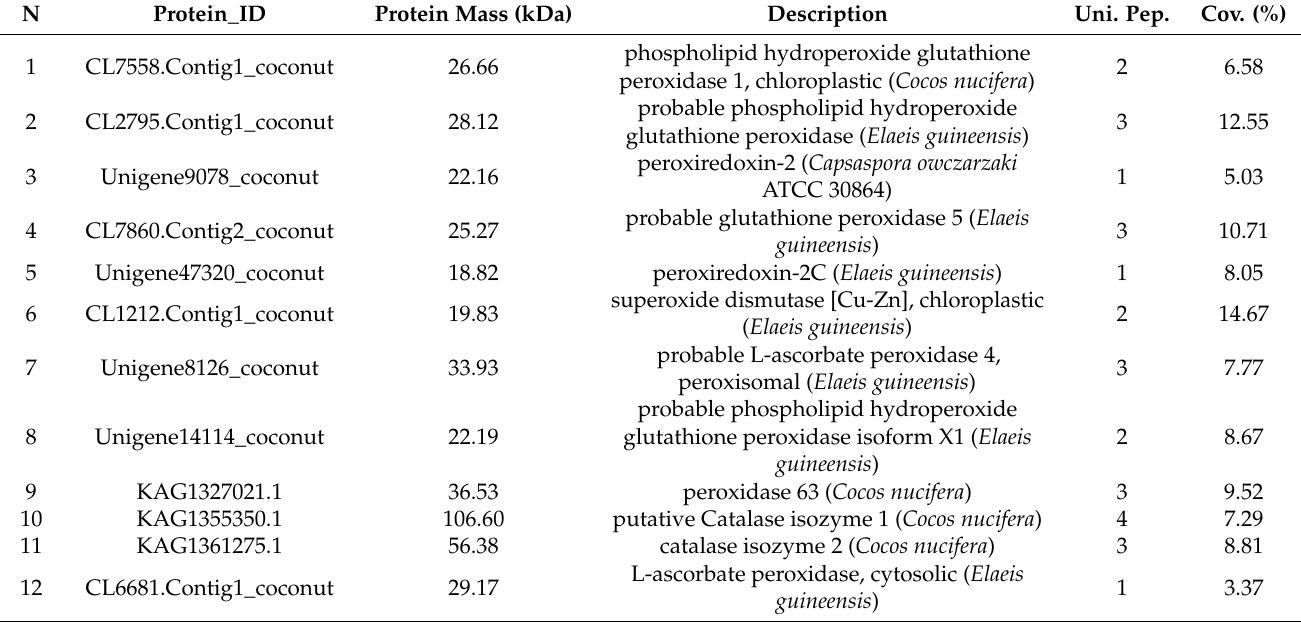
Table 2. C. nucifera proteome (GO class=antioxidant activity, FDR <